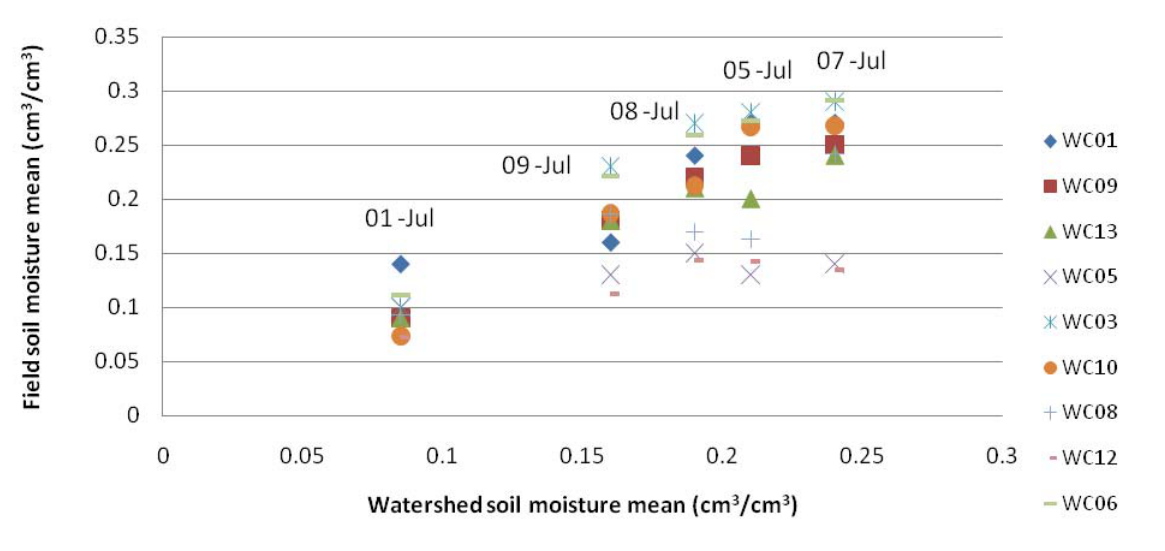
Figure 5 . Comparison between the watershed soil moisture mean values and the field soil moisture mean values for fields that were considered as stable (WC 01, 09, 13) and as non stable (WC05,